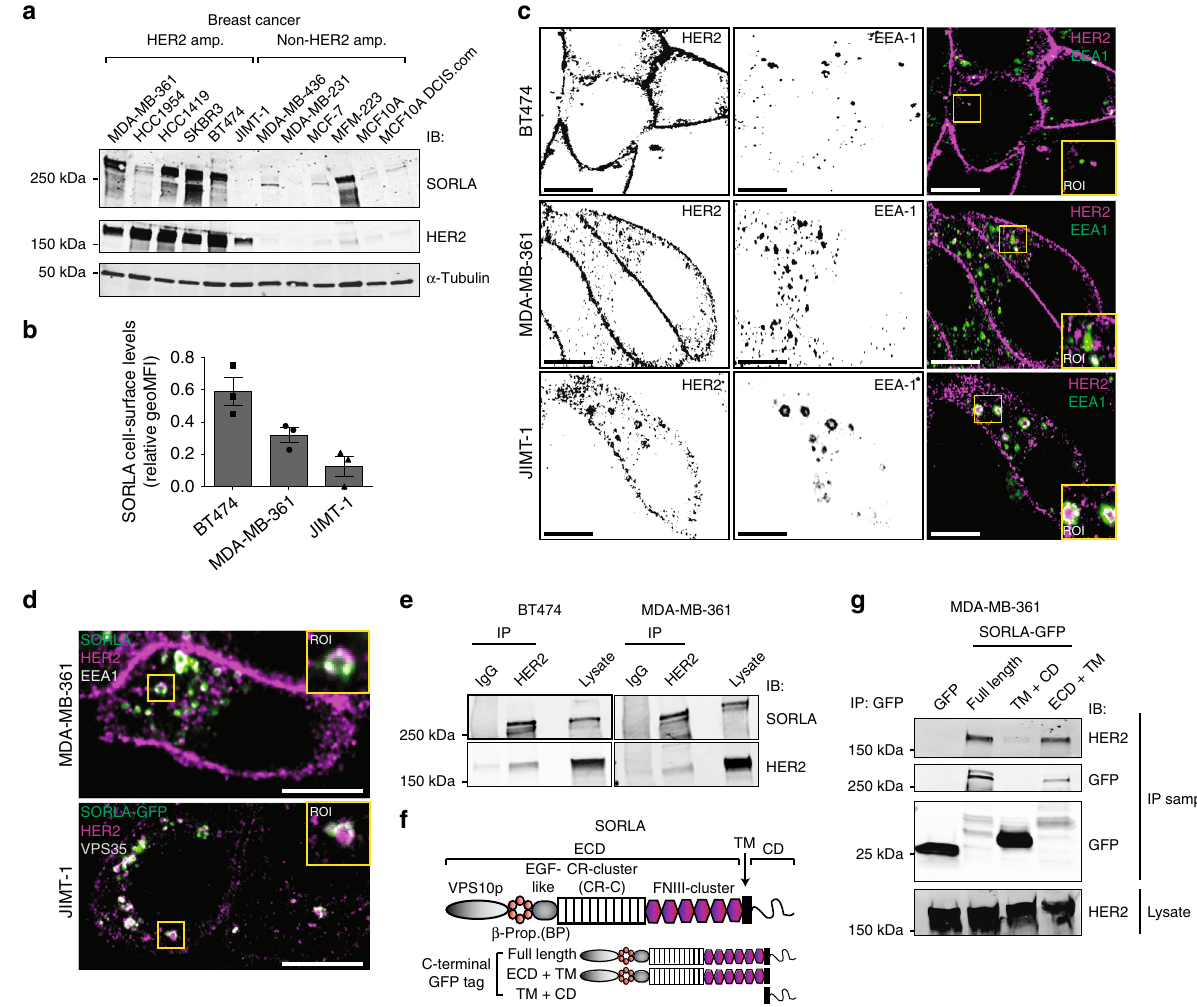
Fig. 1 SORLA is highly expressed in HER2-ampli fi ed breast cancer cells and co-traf fi cs with HER2. a Western blot analysis of SORLA and HER2 protein levels in breast cancer cell lines. α -tubulin is a loading control. b Quanti fi cation of SORLA cell-surface levels by FACS in MDA-MB-361, BT474 and JIMT-1 cells ( n = 3 independent experiments; data are geo mean fl uorescence intensity (MFI) ± standard error of mean (s.e.m.). c Confocal microscopy imaging of HER2 (magenta) and EEA-1 (green) in BT474, MDA-MB-361 and JIMT-1 cells. Co-localisation of the HER2 and EEA1 signals is indicated in white in the merged panels. d Endogenous SORLA (green), HER2 (magenta) and EEA-1 (white) staining in MDA-MB-361 cells (top panel). Endogenous HER2 (magenta) and VPS35 (white) staining in JIMT-1 cells expressing SORLA-GFP (green) (bottom panel). e Co-immunoprecipitation of endogenous SORLA with endogenous HER2 in MDA-MB-361 and BT474 cells. f Schematic of the SORLA protein domains and summary of the constructs used. g Co- immunoprecipitation of endogenous HER2 with different SORLA-GFP fragments in MDA-MB-361 cells. Scale bars: 10 µ m. Where immunoblots and micrographs are shown, these are representative of n = 3 independent experiments; IB immunoblotting, IP immunoprecipitation. ECD extracellular domain, TM transmembrane domain, CD cytosolic